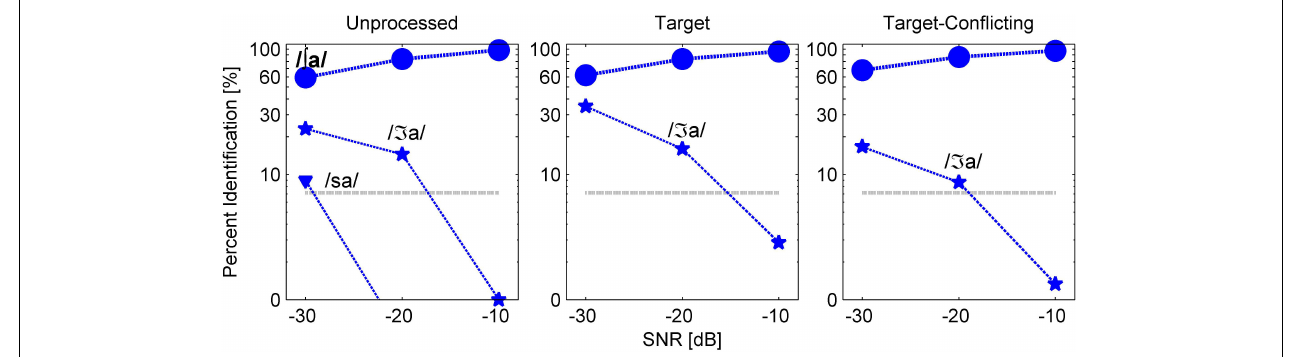
FIGURE 9 | Confusion patterns when / S a/ was presented. A description for the figure is the same as presented in Figure 6